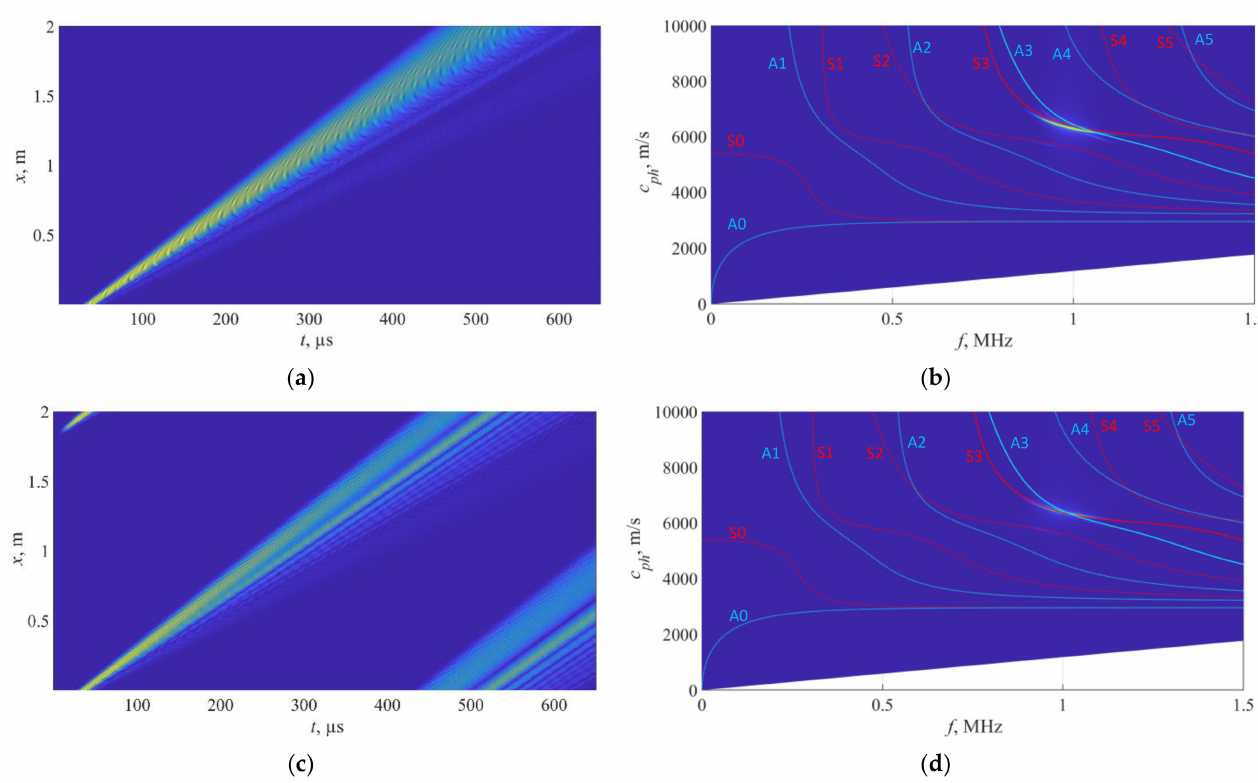
Figure 11. Signals in the case of excitation with apodization: B-Scan of the vertical component of the particle velocity simulated on a ( a ) plate and ( c ) corresponding pipe; phase velocity dispersion curves reconstructed on ( b ) plate and ( d ) pipe.